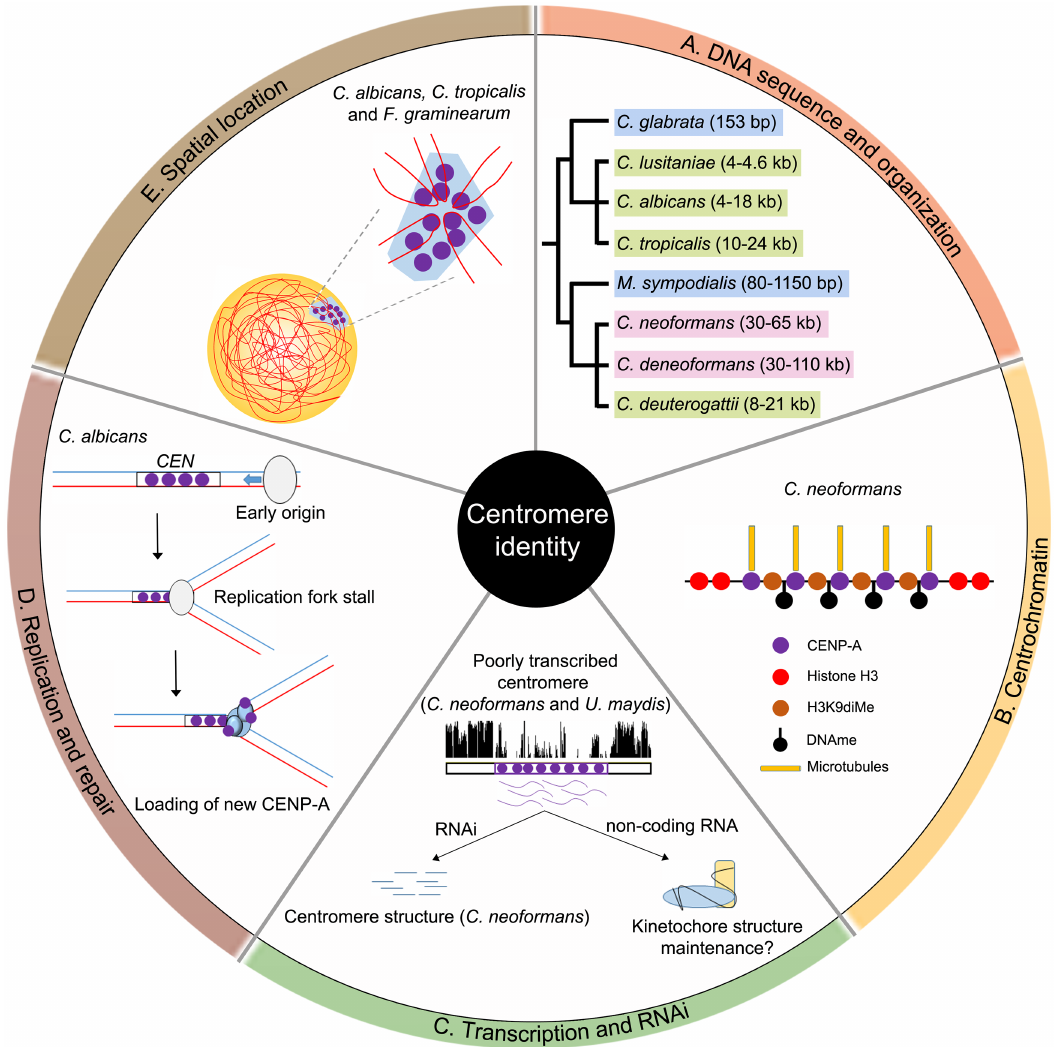
Fig 1. Five key determinants of centromere identity in pathogenic fungi. (A) The length and type of centromeres in various pathogenic fungi have been depicted in a cladogram. Candida glabrata and Malassezia sympodialis have point centromeres (blue); C . albicans , C . tropicalis , and Cryptococcusdeuterogattii have small regional centromeres (green); and C . neoformans and C . deneoformans harbor large regional repetitive centromeres (pink). (B) Centromeric heterochromatin or centrochromatin refers to the various chemical modifications associated with the histones (both canonical and variant) as well as DNA at the centromeric locus. For example, centromere DNA is methylated at cytosines, and CENP-A nucleosomes are interspersed with H3K9-dimethylated nucleosomes in C . neoformans . (C) Transcription and a functional RNAi machinery at the centromere are required to preserve centromere identity in some organisms. The centromeres in the Ustilago and Cryptococcus species complexes are poorly transcribed. In C . neoformans , centromeric transcription is regulated by the RNAi machinery that silences centromeric retrotransposons to stabilize centromere structure. Unprocessed long noncoding RNA, whose function is unknown, is also produced from centromeres in this species. (D) DNA replication and repair proteins are known to play a key role in C . albicans centromere stability. The centromere proximal origins help in maintaining centromere function in this organism. Replication forks converging toward the centromere stall randomly, which leads to accumulation of single-stranded DNA (ssDNA) that recruits repair proteins like Rad51 and Rad52, along with new CENP-A molecules in C . albicans . (E) The spatial location of centromeres within the nucleus determines its activity and interaction with other nuclear subcompartments. All centromeres are clustered toward the nuclear periphery to form a CENP-A–rich zone in C . albicans and many other pathogenic fungi. This preferential spatial distribution helps to determine the site of centromere assembly in every cell cycle. CENP-A, centromere protein A; H3K9, histone H3 lysine 9; Rad, radiation sensitive; RNAi, RNA interference; ssDNA, single-stranded